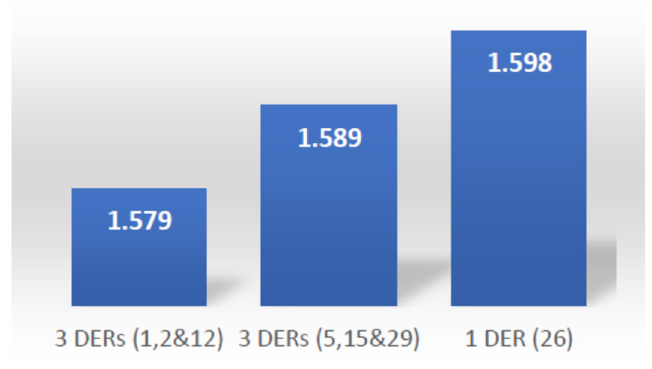
Figure 11. System eigenvalue comparison.